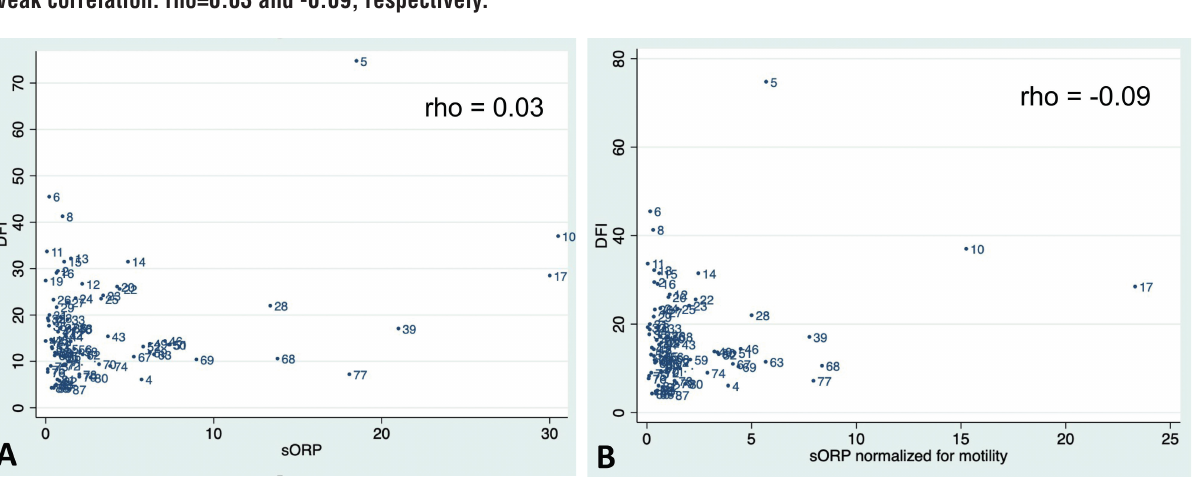
Figure 3 - Scatterplot of the correlation between Sperm DNA Fragmentation and Seminal Oxidation Reduction Potential, excluding patients with sperm concentration below 1 million/mL. A total of 86 patients was included. As raw data did not meet the assumptions to fit a linear model, a Spearman's rank correlation was run to test the overall hypothesis of monotonic correlation between sORP and DFI (A), and sORP normalized for motility and DFI (B). The test indicated a very weak correlation: rho=0.03 and -0.09,